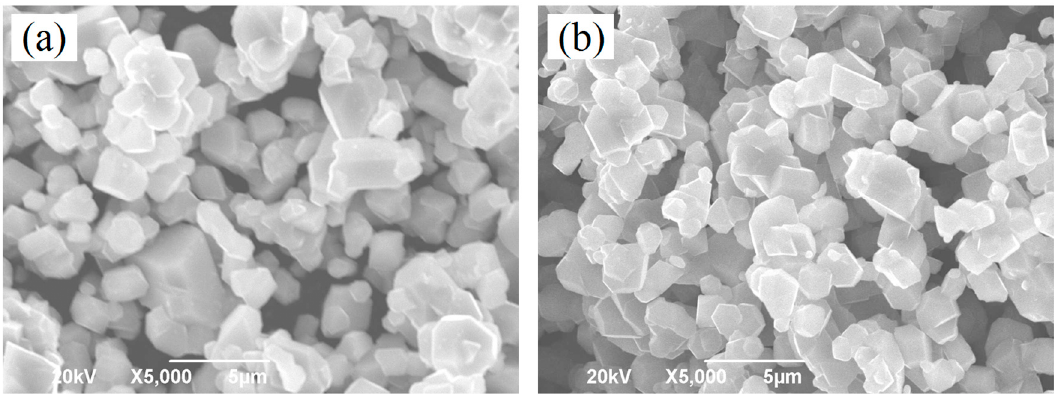
Figure 2. SEM images of the LiNi 0.5 Mn 1.5 O 4 ( a ) and Er-doped LiNi 0.5 Mn 1.5 O 4 ( b ).